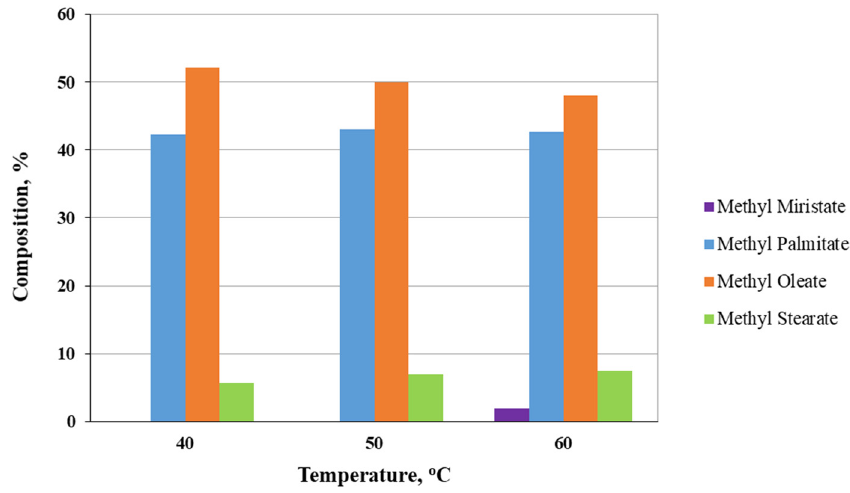
Figure 6: Major FAME composition for various temperatures.